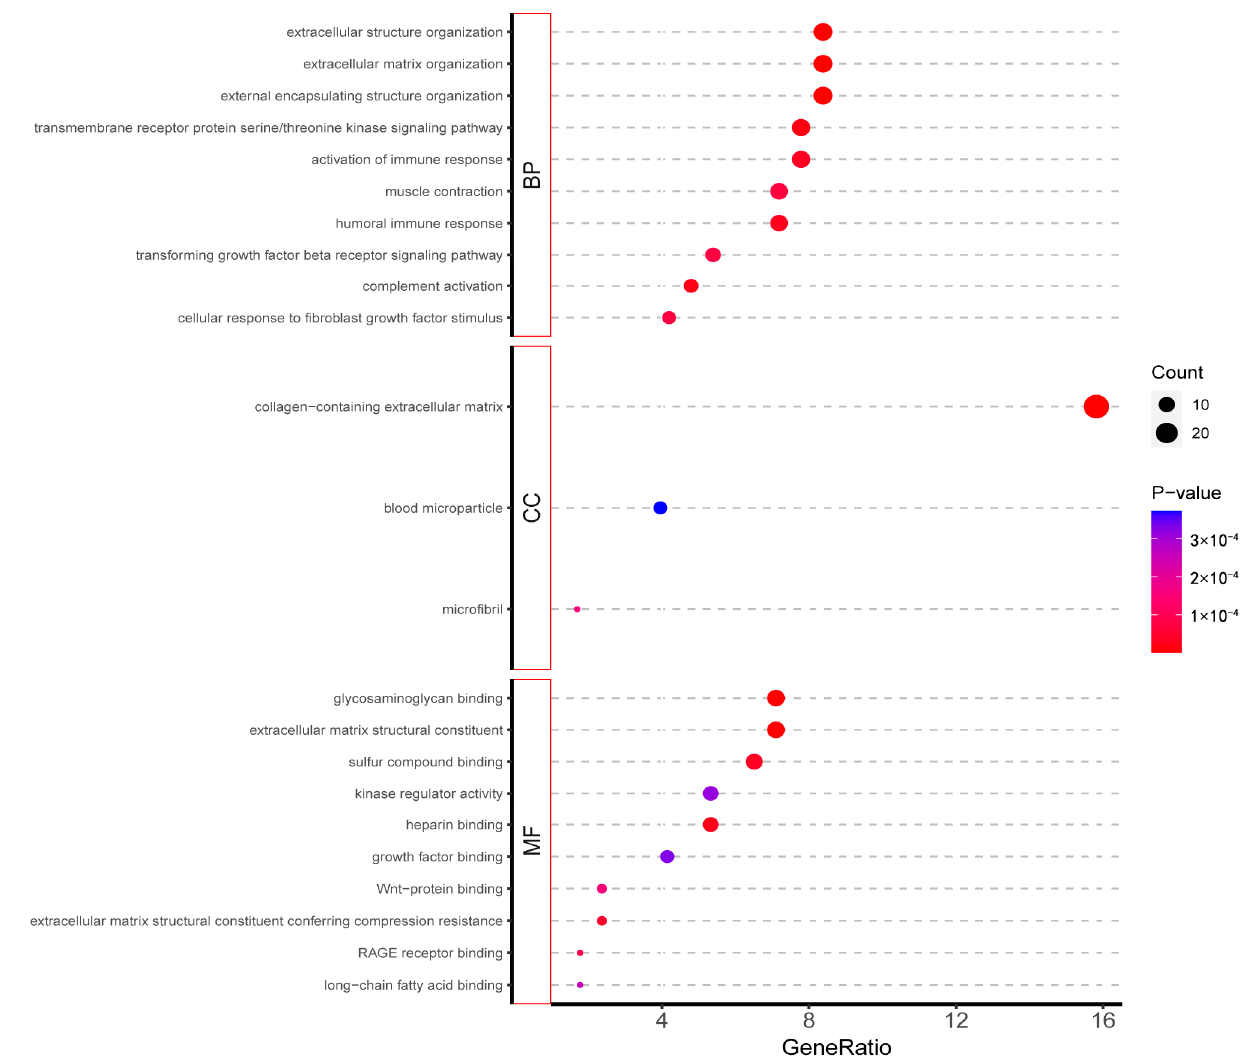
Figure 2. GO enrichment analysis results of RRA-analysed differential genes.